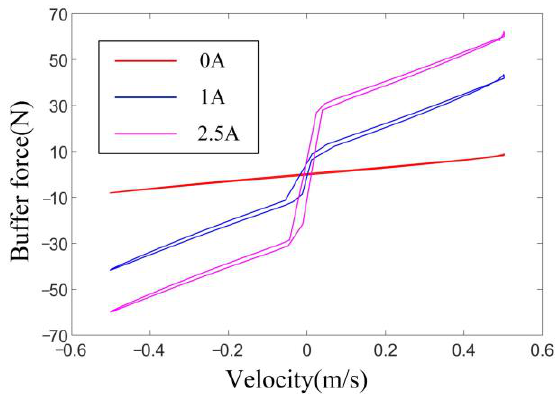
Figure 12. Curve between buffer force and velocity of the VSB.